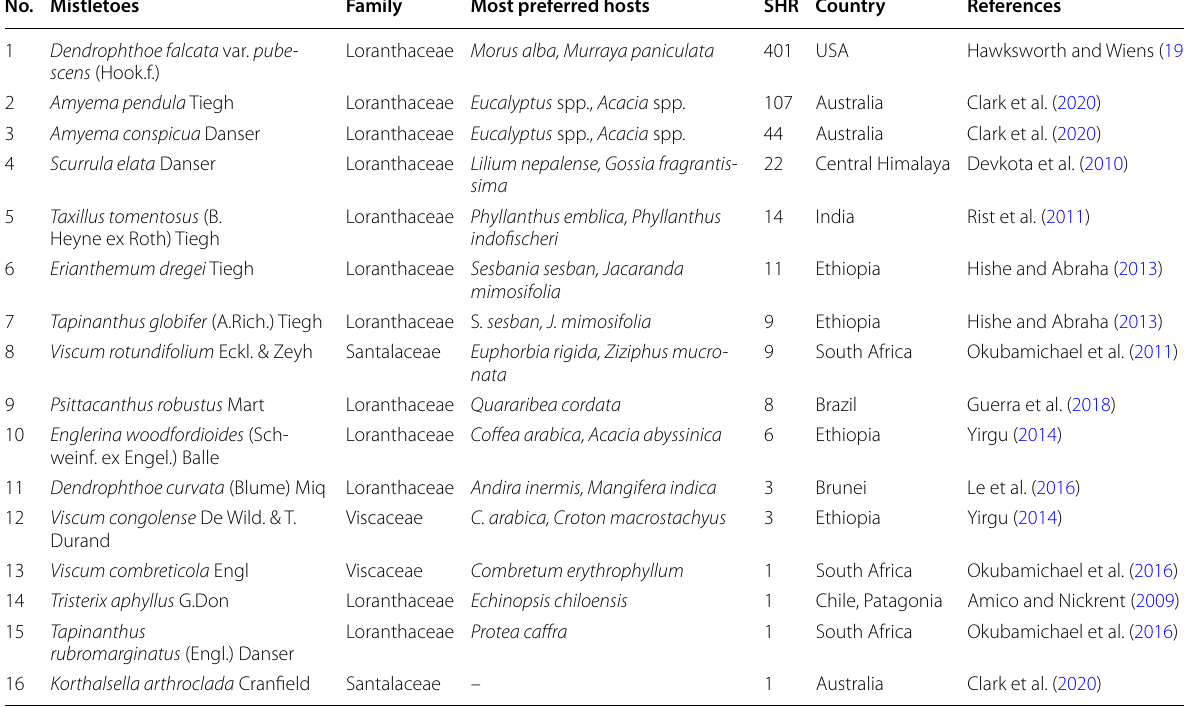
SHR, Species host range